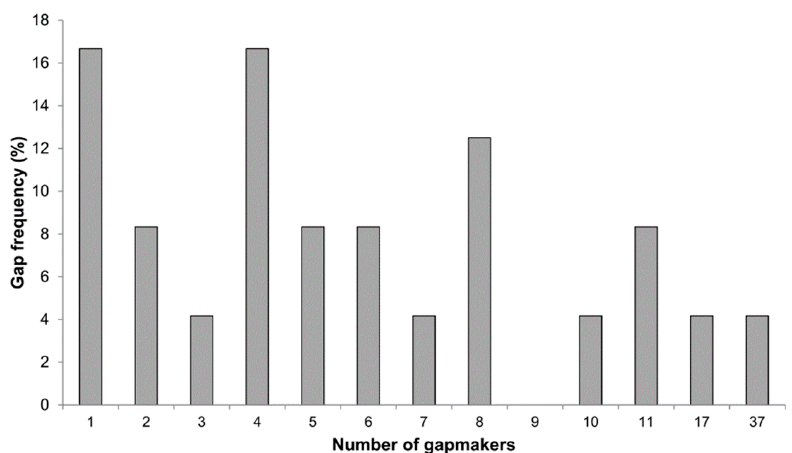
Figure A2. Gap frequency according to number of gapmakers.